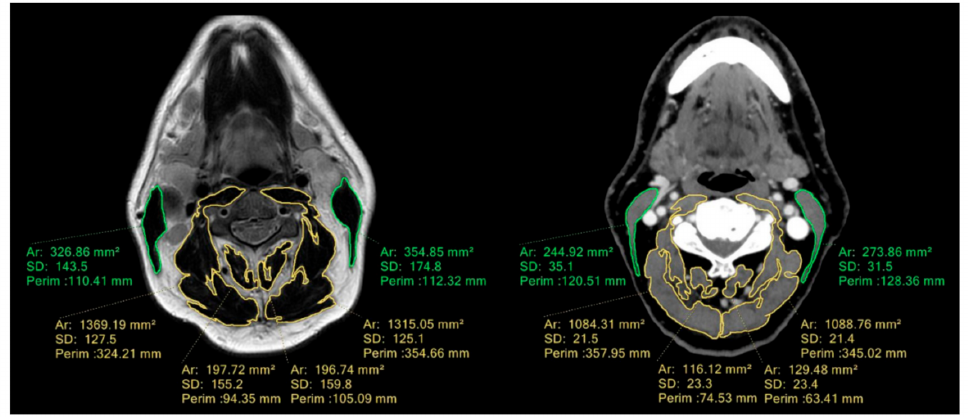
Figure 3. Segmentation of sternocleidomastoid (green) and paravertebral muscles (yellow) at C3 level using MRI ( left ) and CT ( right ) imaging in two different